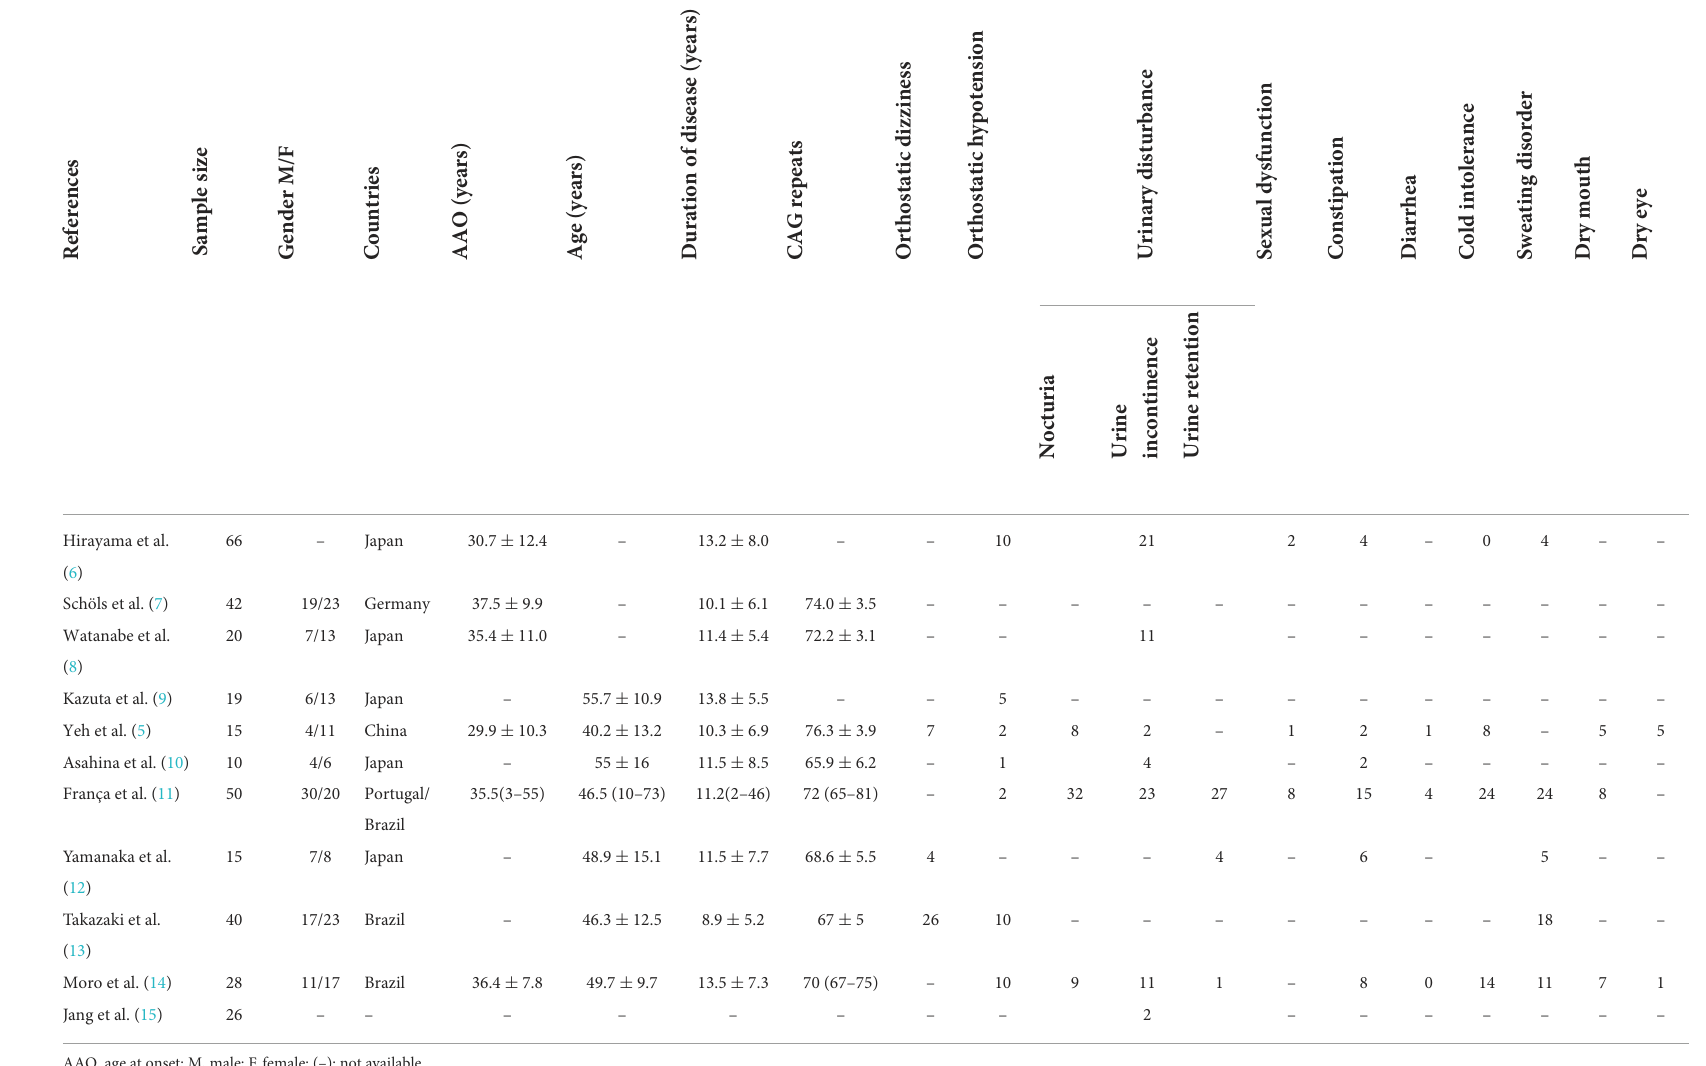
TABLE 1 Clinical factors and autonomic dysfunction from published